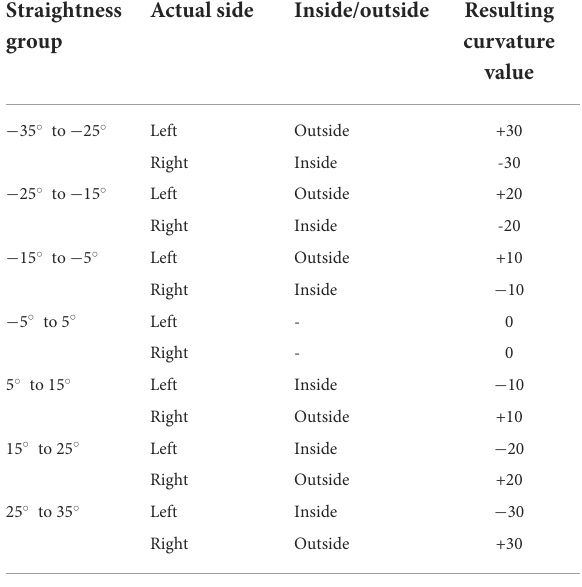
TABLE 9 Results of multi-factor ANOVA.